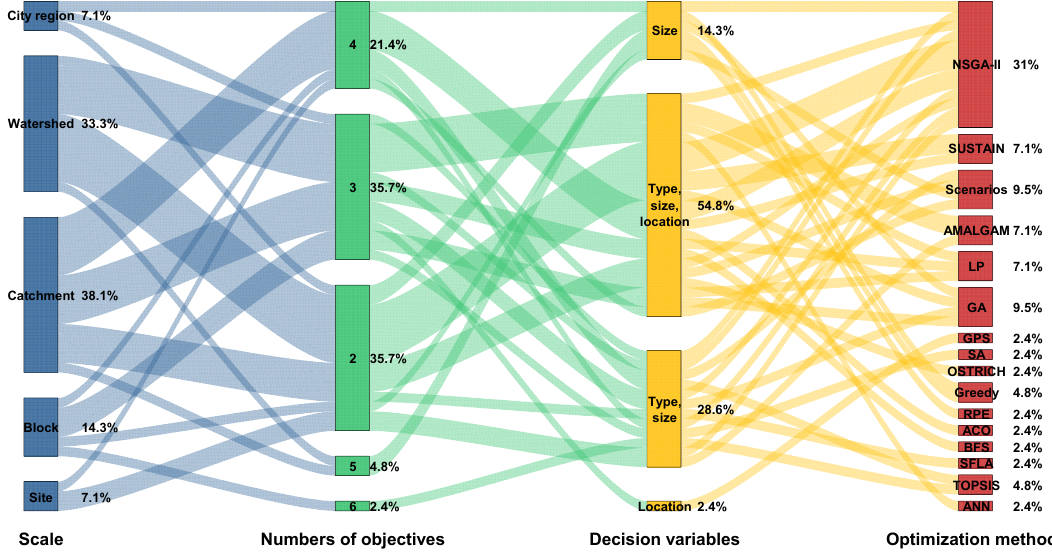
Figure 10. Alluvial diagram for different studies examined in this study.